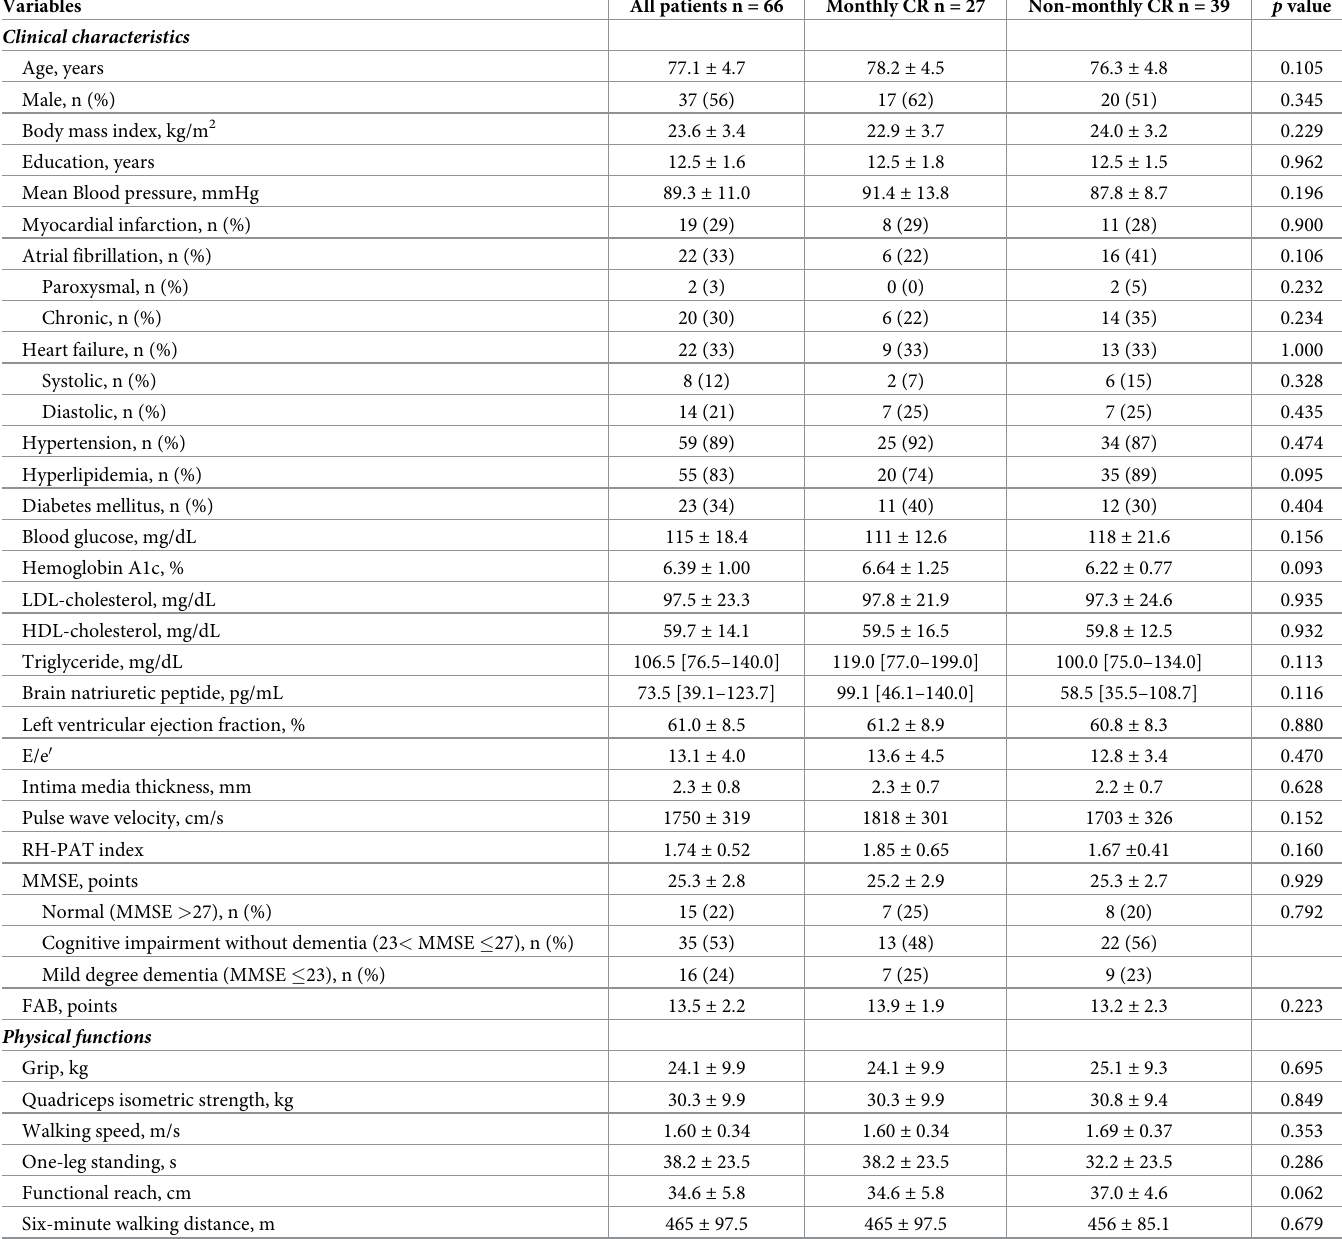
Table 1. Baseline patient